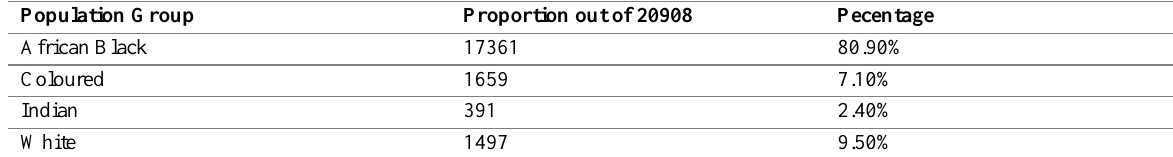
Table 2: Distribution of the